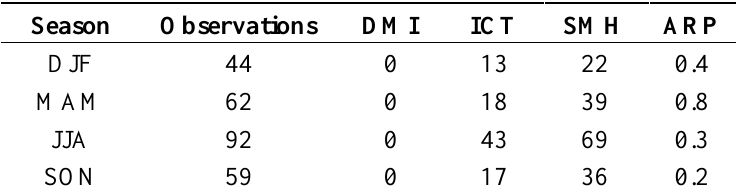
Table 3. Percent of dry days before correction (control period).